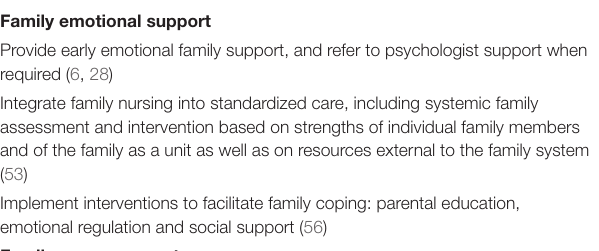
TABLE 3 | Recommendations for the support of families with CCI patients. Family emotional